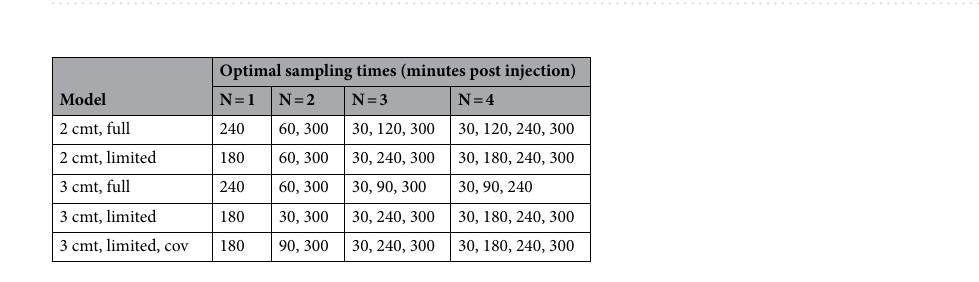
Table 3. Combinations of sampling times with N = 1 to 4 samples providing the lowest root mean squared error concerning clearance based on stochastic simulations.